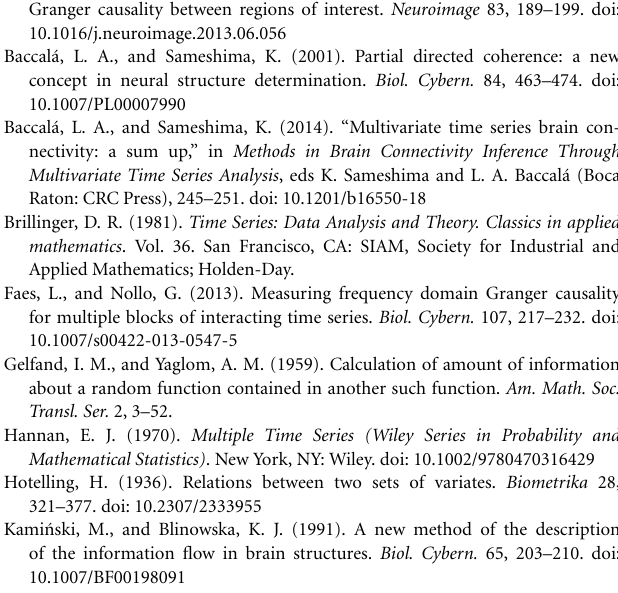
lines) showing scalp electrode set connections shown in (A) . Notice some divergences between gPDC and cPDC graphs possibly due the lack of proper rigorous statistics usage for cPDC significance level estimation, for instance, there is cPDC from RO to LO (B) , but gPDC O2 to O1 is absent (A) , while there is gPDC from C4 to T1 without corresponding cPDC from RC to